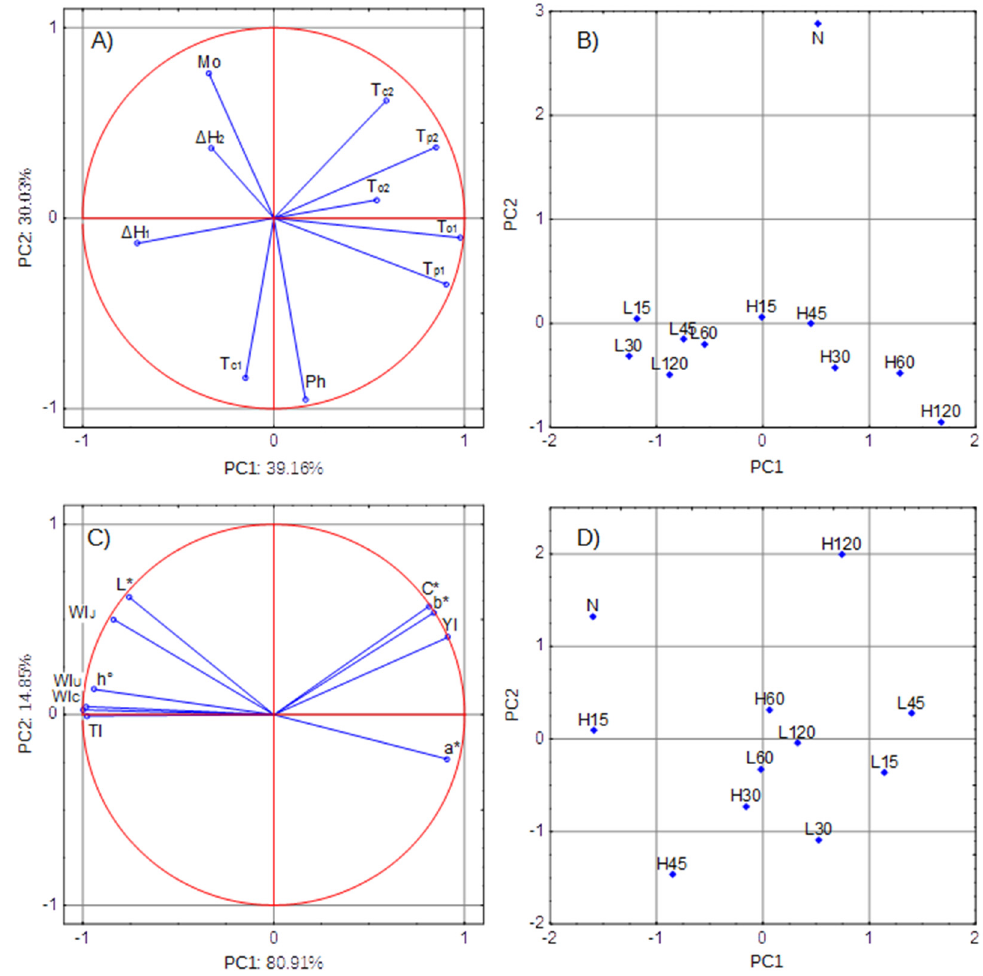
Figure 5. Principal component analysis: PCA: ( A ) distribution of parameters of the internal structure of the granule-loading plot (Mo-moisture, Ph-phosphorus content), ( B ) distribution of starch samples based on the internal structure-score plot, ( C ) distribution of color parameters-loading plot, ( D ) distribution of starch samples based on color-score plot.